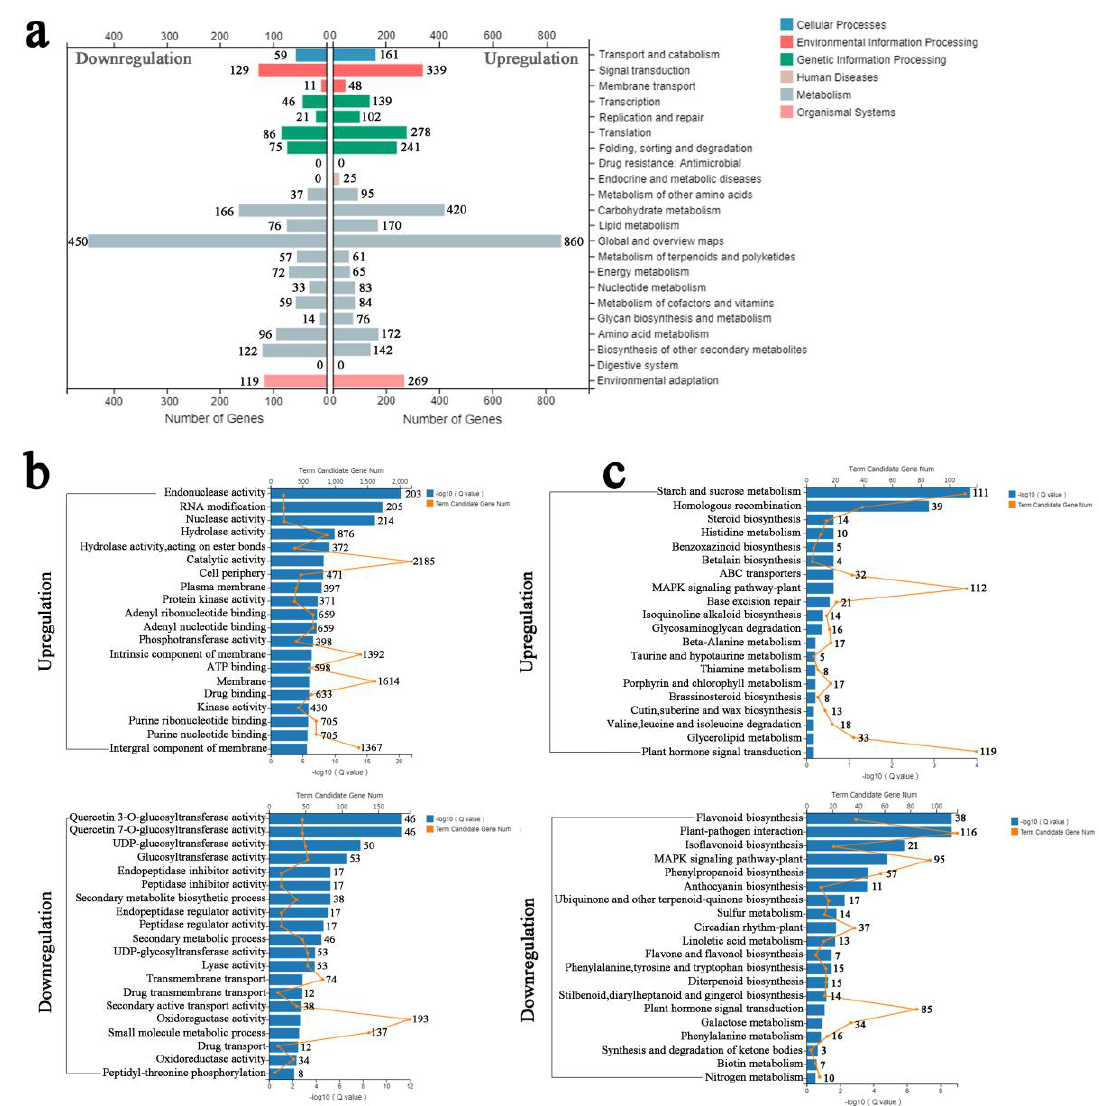
Figure 5. Upregulation and downregulation of GO enrichment and KEGG analysis of di ff erential genes. ( a ) KEGG classification of upregulated and downregulated DEGs. The left side is the upregulated KEGG analysis, and the right side is the downregulated KEGG analysis. ( b ) Upregulation and downregulation of GO enrichment analysis of di ff erential genes. ( c ) Upregulation and downregulation of KEGG enrichment of di ff erential genes. The blue columns are expressed as − log 10 (Q value), and the orange line graph represents the number of candidate genes. The gene numbers were indicated after the columns.